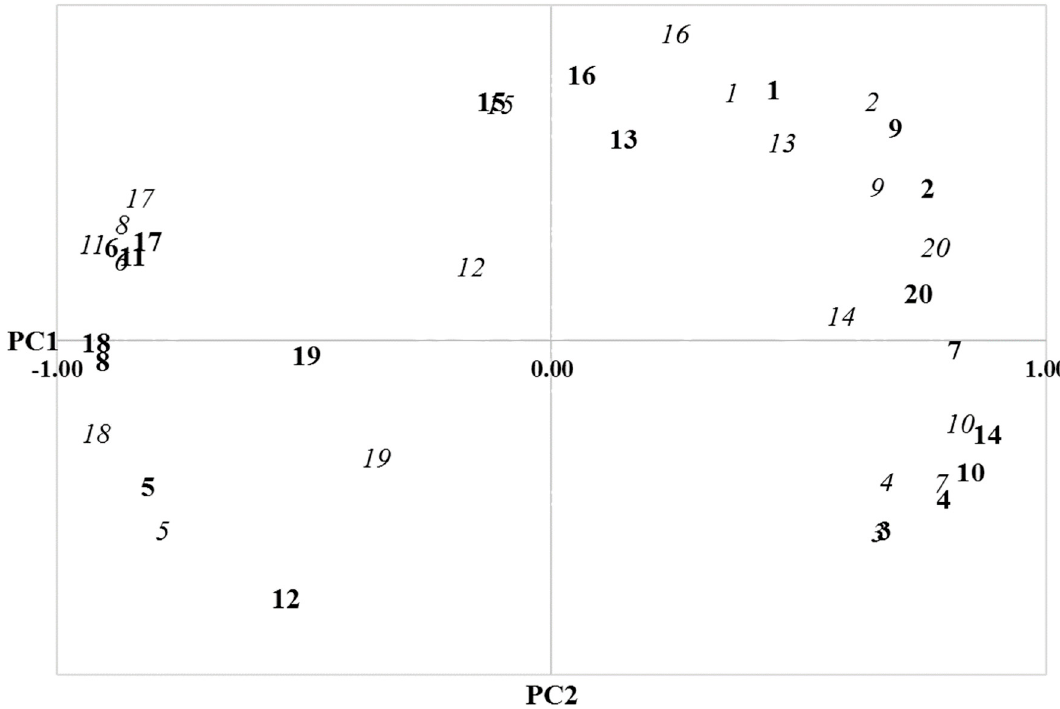
Figure 1. Plotted factor loadings of the first two principal components (PC; PC1 and PC2) for the